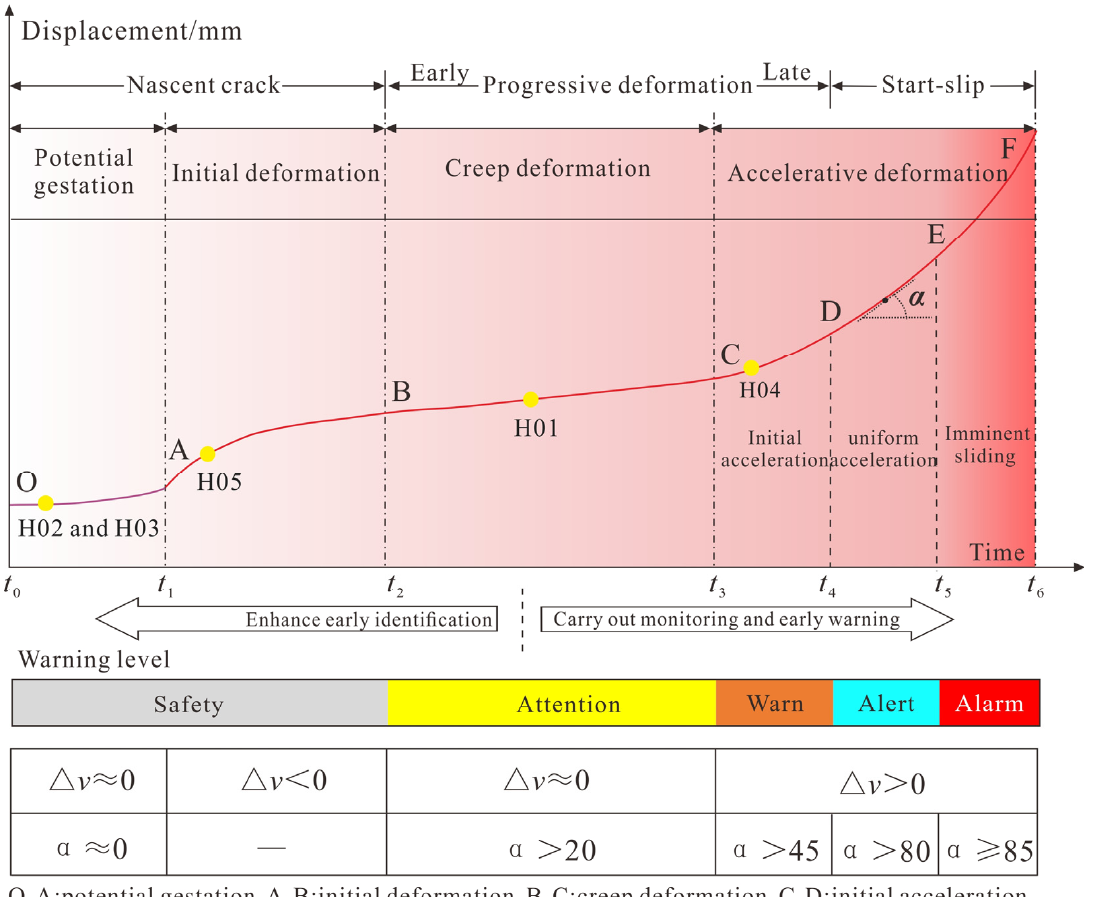
Figure 12. Deformation stage curve of a large deep-seated creeping landslide (modified after [43,54]).